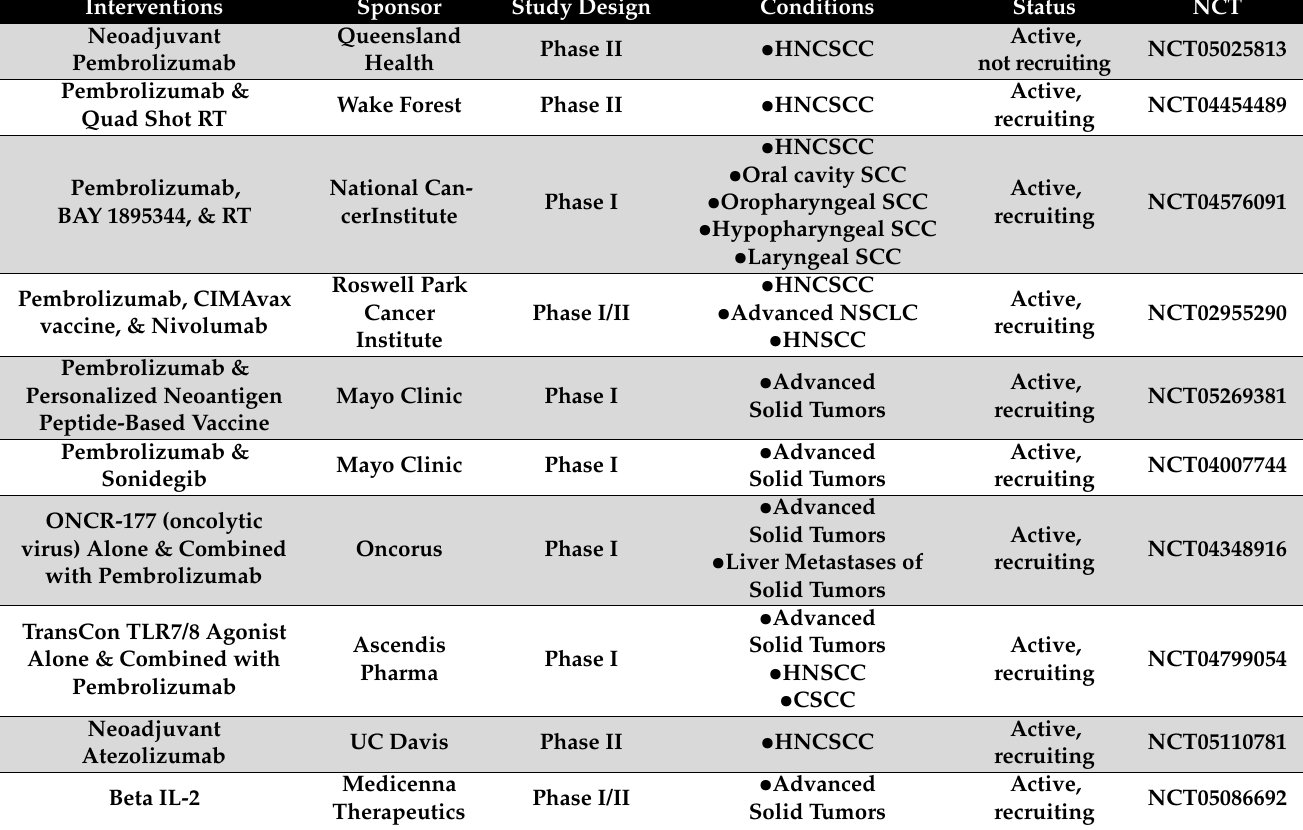
Table 1. Current Immunotherapy Clinical Trials in HNCSCC.